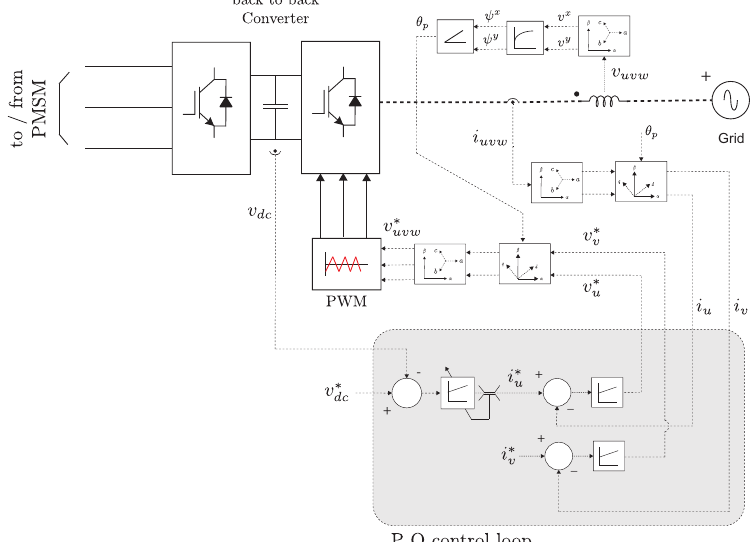
Figure 5. Voltage-oriented control